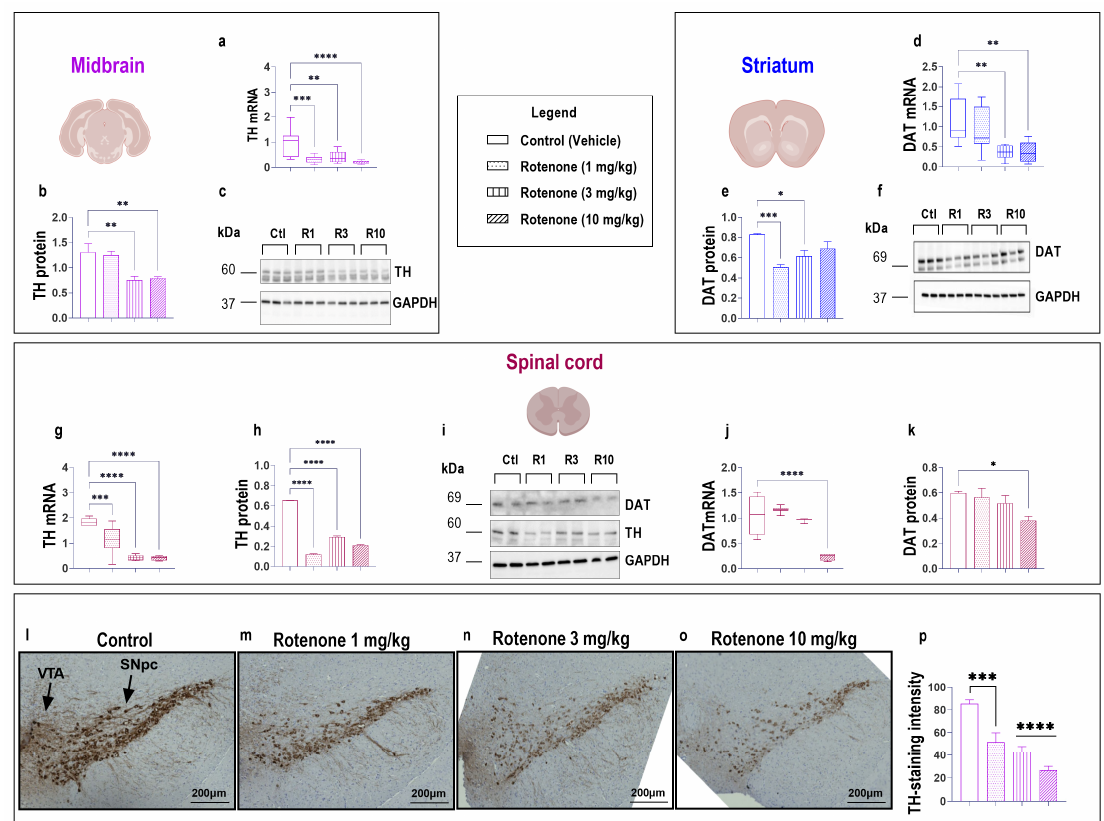
Figure 2. Rotenone reduces the expression of dopaminergic markers in the midbrain, striatum and spinal cord. On day 22, mice from vehicle- and rotenone-treated groups (1, 3 and 10 mg/kg) were sacrificed and midbrains, striata and spinal cords were collected for molecular analyses. TH mRNA and protein expression in the midbrain ( a – c ). DAT mRNA and protein expression in the striatum ( d – f ). TH and DAT mRNA and protein expression in the spinal cord ( g – k ). Representative photomicrographs showing TH-immunoreactivity and semi-quantitative measurement of staining intensity in the midbrain of vehicle-, 1, 3 and 10 mg/kg rotenone-treated mice ( l – p ). At least two sections from n = 3 mice per group were used for semi-quantitative analyses of staining intensity. Scale bar = 200 µ m. Gene expression was measured using real-time qPCR and quantified using the ∆∆ Ct method after normalization to s18 (ribosomal protein s18 gene), the housekeeping gene. Real-time qPCR results are presented as mean fold changes with respect to vehicle-treated mice (control). In Western blots, protein expression was normalized to GAPDH, used as the loading control. Densitometry results are expressed as mean ± S.E.M. Data in qPCR, Western blots and immunohistochemistry represents means of n = 4 samples for each group. * p < 0.05, ** p <